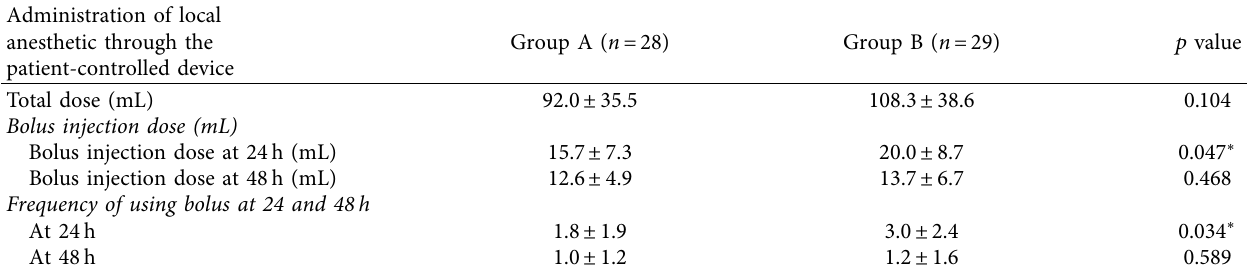
Table 4: Administration of local anesthetic through the patient-controlled device.